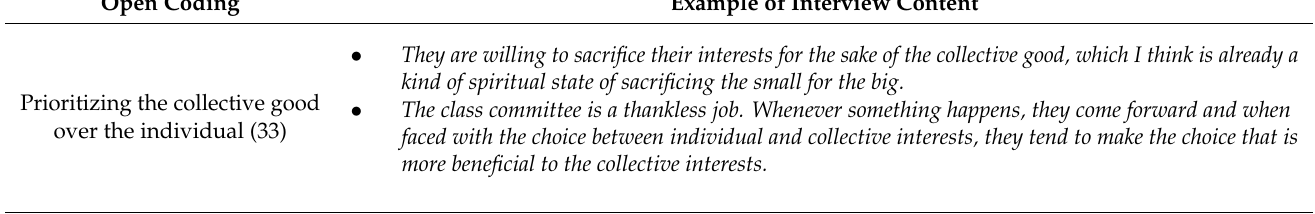
Table 6. Material information of the sub-node “collectivist tendency” by axial coding. Open Coding Example of Interview